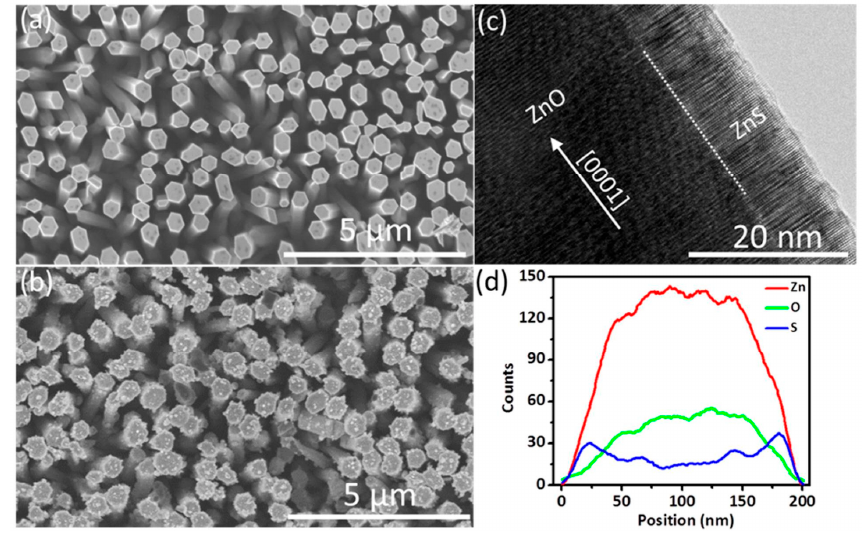
Figure 4. Structural characterization of a ZnO/ZnS core/shell nanowire showing low magnification top view, FESEM images of: ( a ) an as-grown, ZnO nanowire array; and ( b ) a ZnO/ZnS core/shell nanowire array; ( c ) an HRTEM image of a single ZnO/ZnS core/shell nanowire; and ( d ) the corresponding energy dispersive spectroscopy (EDS) lateral line scan depicting elemental peaks characteristic to core/shell nanowire structure. Reproduced with permission from [35], Copyright 2015, American Chemical Society.